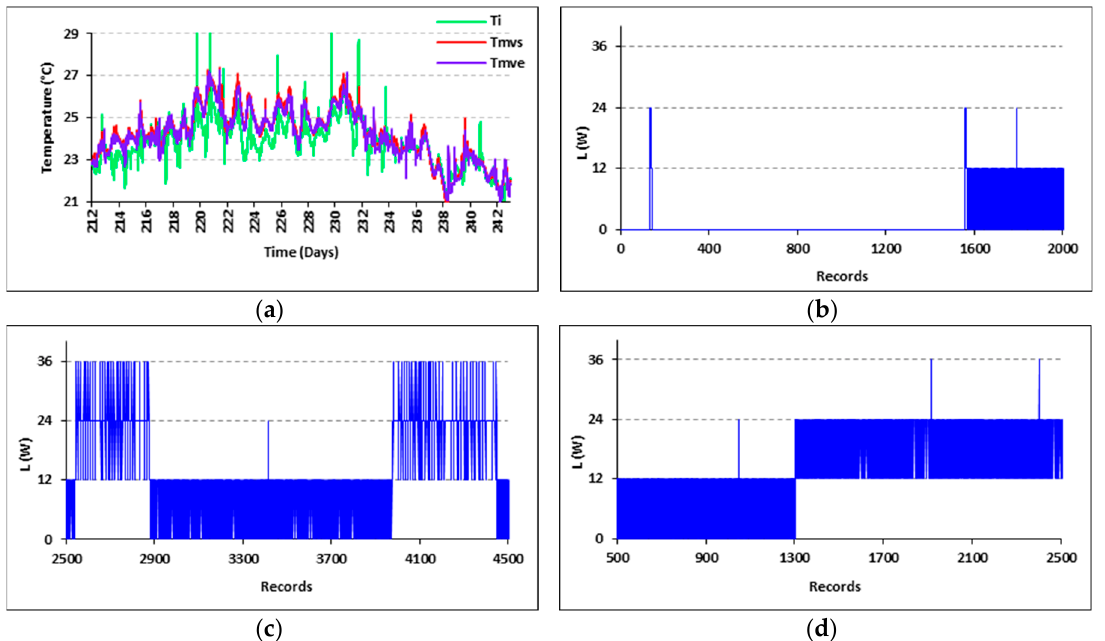
Figure 4. Measurements of the variables of the mechanical ventilation system. Temperatures and electricity consumption for selected months with di ff erent working regimes recorded every five minutes: ( a ) extract and supply temperatures compared to the indoor air temperatures in July 2012–November 2012; ( b ) electricity consumption in February 2013 (when the room was positively empty according to the instruction document); ( c ) electricity consumption in July 2013; ( d ) electricity consumption in February 2014.